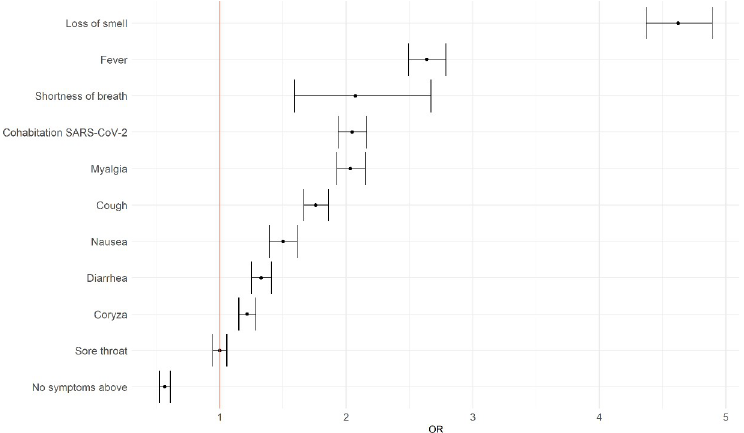
Fig 2. The results of all combinations and metrics can be seen in the S1 Table.